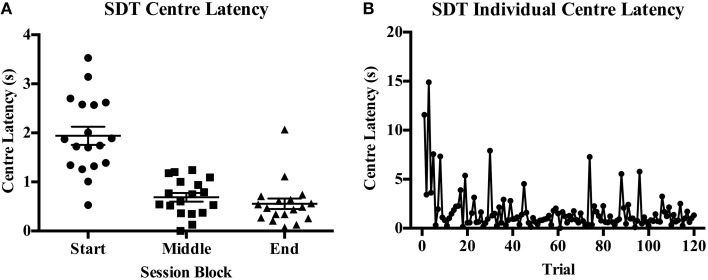
Variability in center latency time on the SDT across session blocks. (A) A scatterplot of the mean center latency values for each individual within each block. (B) A plot of an individual rat's trial-by-trial values for center latency across a session. Of interest is the occurrence of higher values in the initial trials of a session followed by more consistent, short latencies throughout the rest of the session.